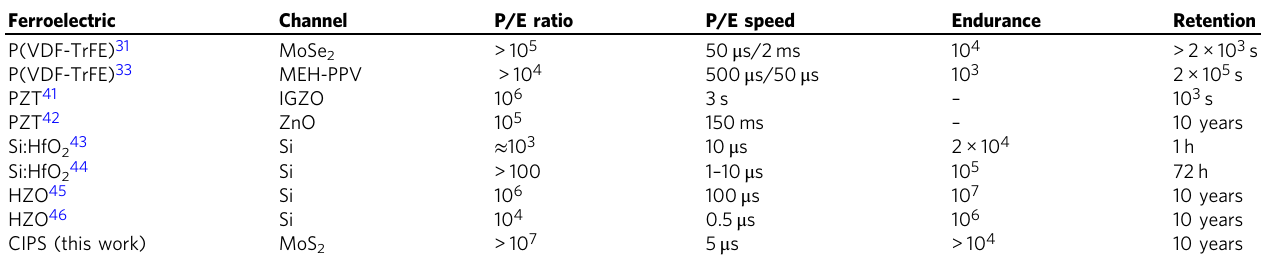
Table 1 Comparison of this work and previous works that employed ferroelectric P(VDF-TrFE), PZT and hafnium oxide as the gate dielectric of